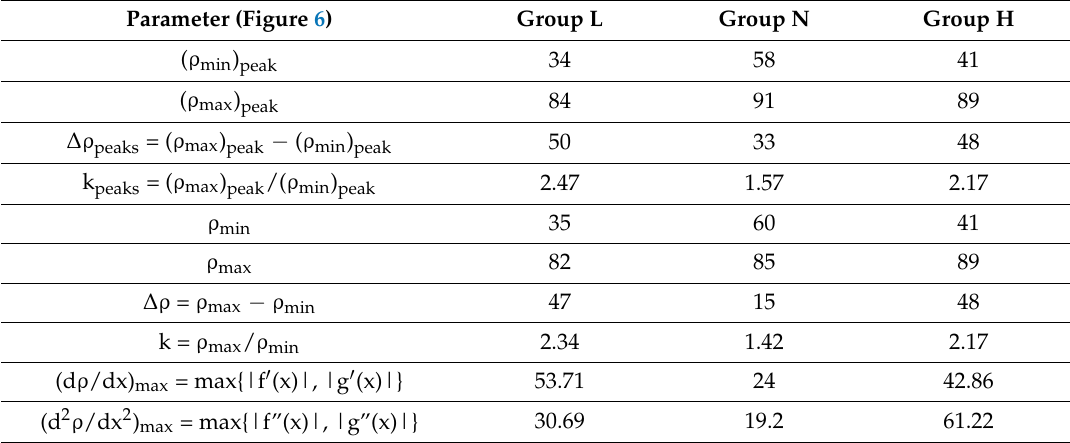
Table 7. Parameters of the reflectivity profiles, graphs, and functions—for pressed ceramic dental prostheses.